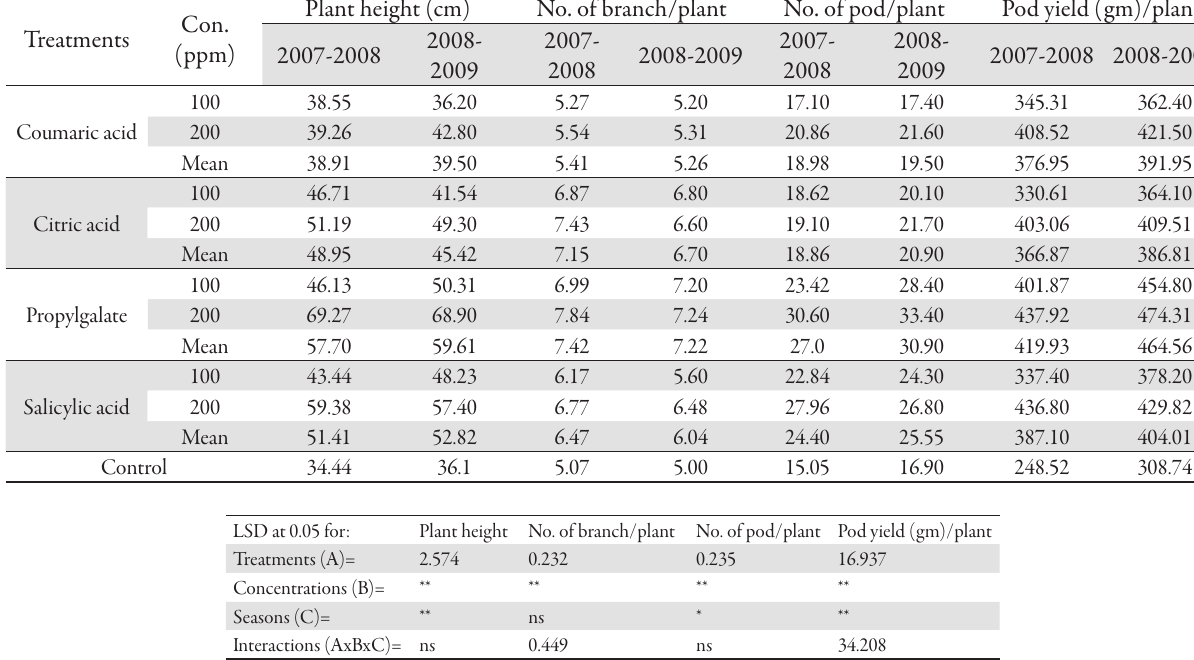
field condition in season 2007-2008 and 2008-2009 Treatments